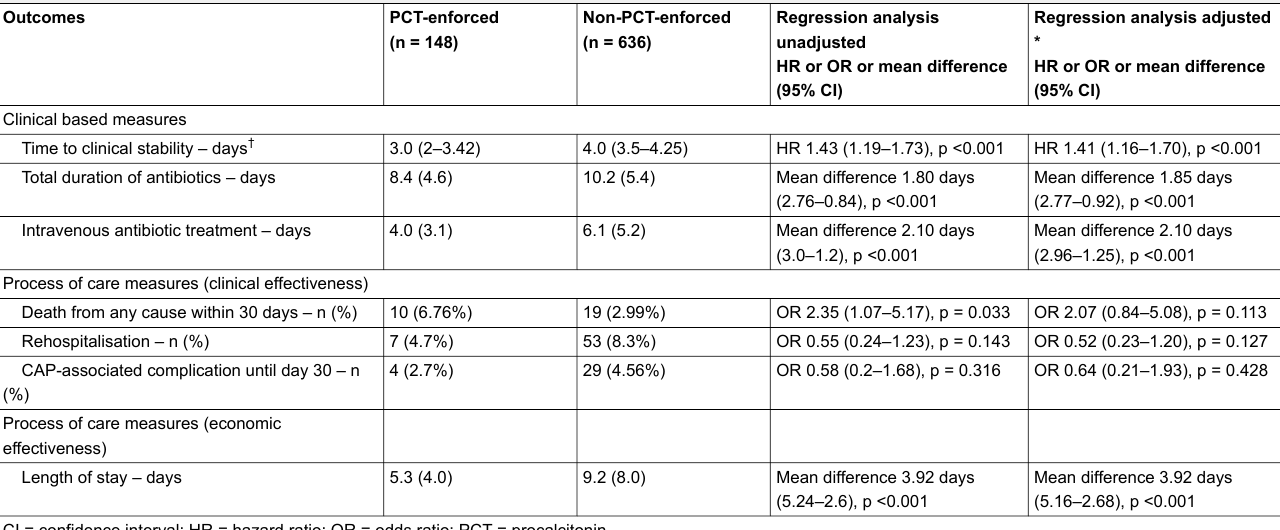
Table 2: Patient outcomes according to use of antibiotic stewardship protocol including procalcitonin. Outcomes